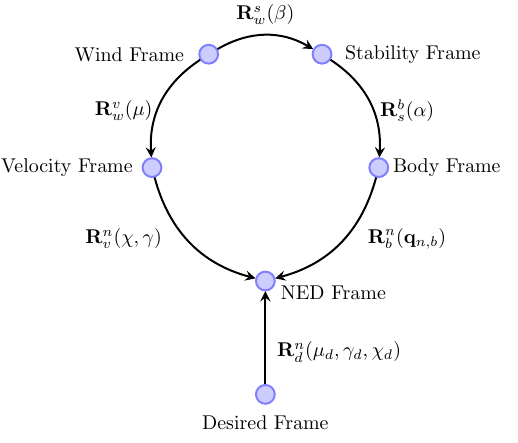
Figure 1: Different reference frames to consider when designing a flight controller (Inspired by Stengel